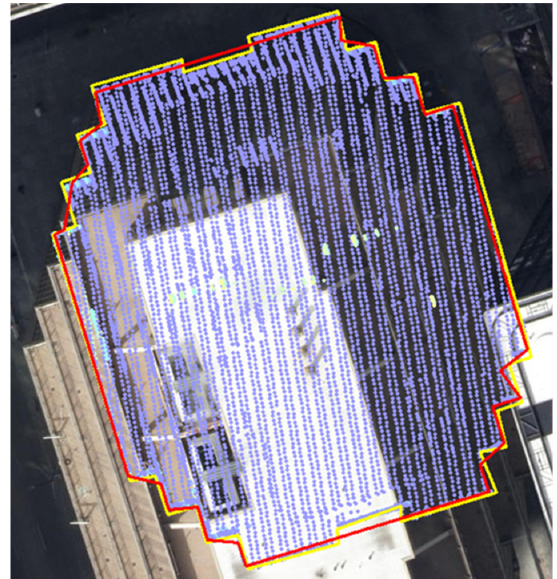
Figure 19. Example in Toronto